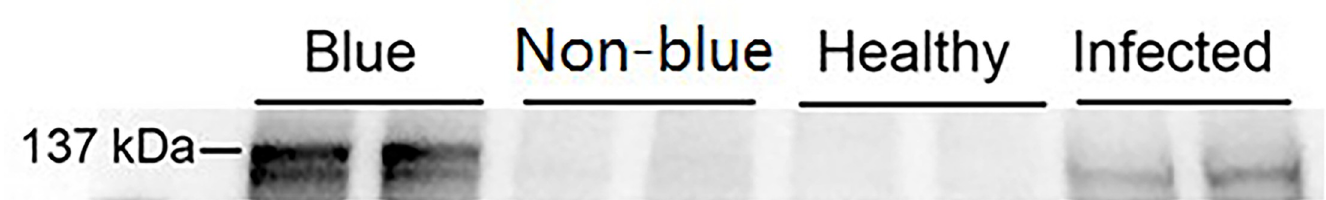
Fig 5. Western blot analysis of hemocyanin protein expression in D . citri . Twenty μ g of protein extracted from each of the four D . citri samples was used in western blot analysis. Blue: blue color morph adults reared on healthy sweet orange. Non-blue: non-blue color morph adults reared on healthy sweet orange. Healthy: non- exposed adults reared on healthy citron. Infected: C Las-exposed adults reared on infected citron.